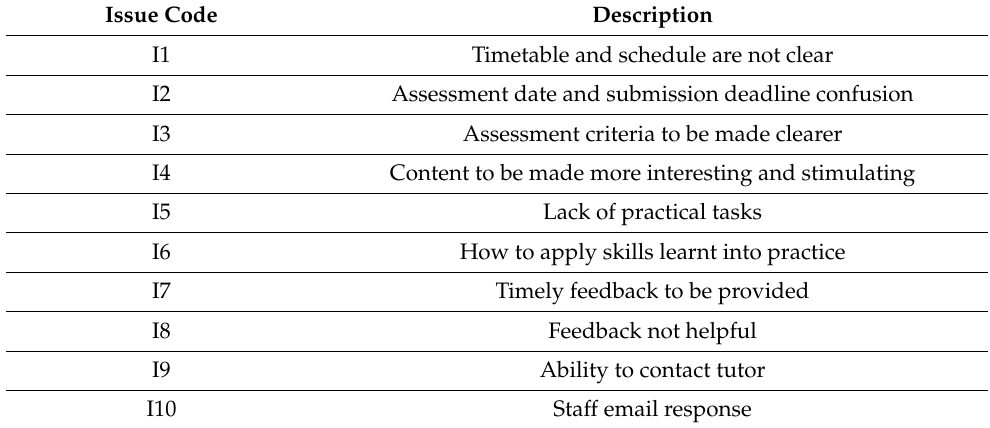
Table 3. Issue code (I1–I10) and